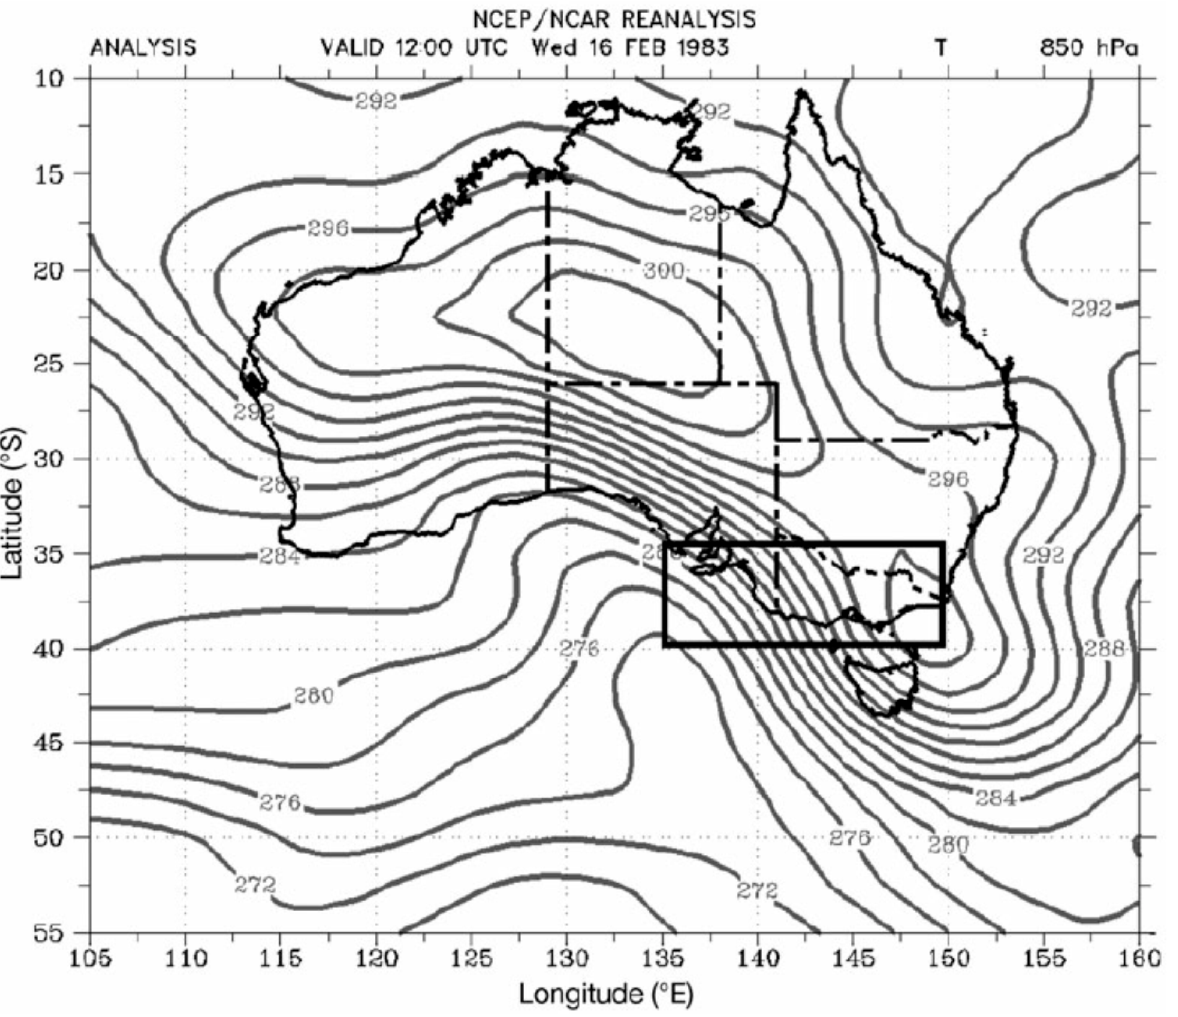
Figure 6. The NCEP/NCAR reanalysis of 850-hPa temperature field [K] at 1200 UTC, 16 February 1983 (Ash Wednesday; [110]).